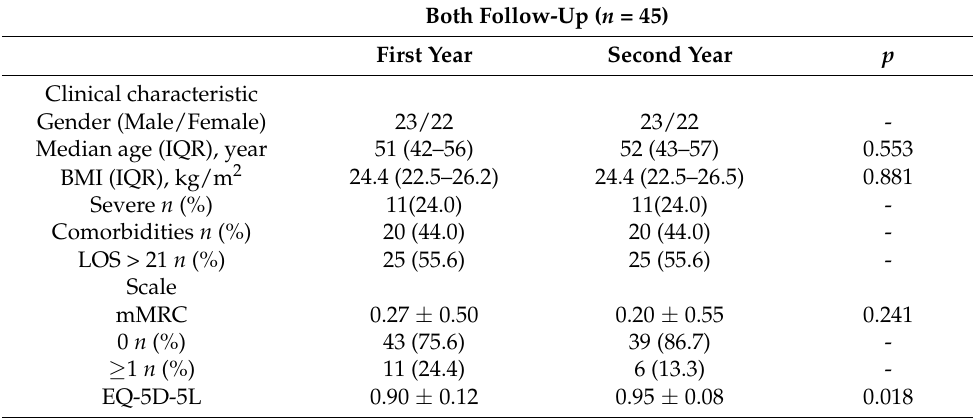
Table 2. Demographic characteristics and mMRC, EQ-5D-5L, GHQ-12, and IES-R PTSD scores of recovered COVID-19-recovered subjects who completed both follow-ups. Both Follow-Up ( n =